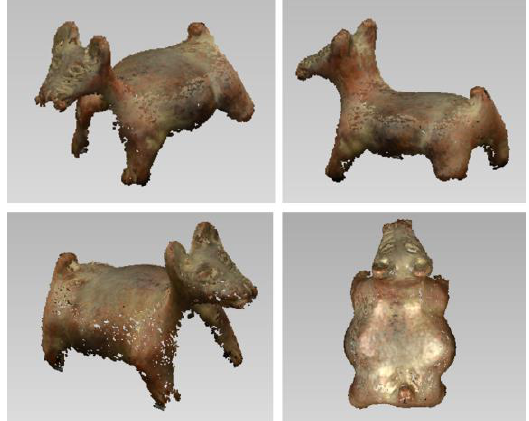
Figure 10. Result of OSGM, colour coded point cloud The comparison between matching result and fringe projection measurement focuses on the evaluation of the matching accuracy. Figure 11 shows the colour-coded 3D deviations (shortest distance between each point to the TIN of the fringe projection measurement, calculated by Geomagic):